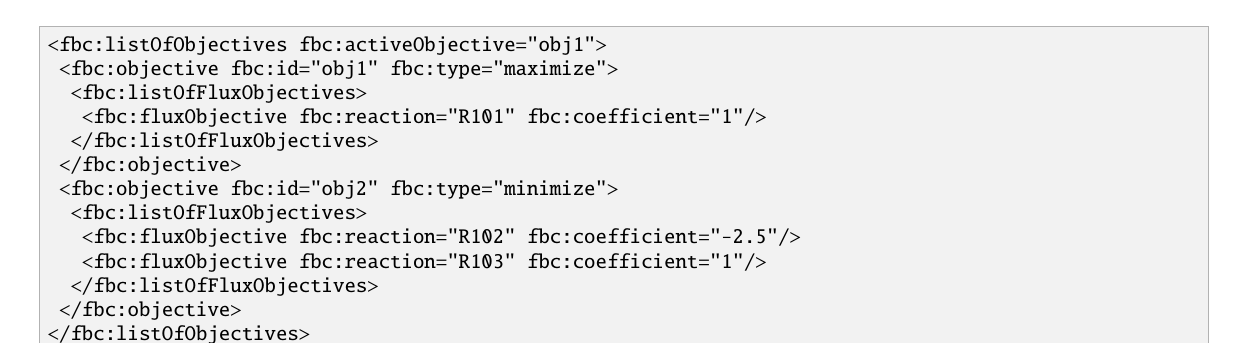
Encoding the Objective